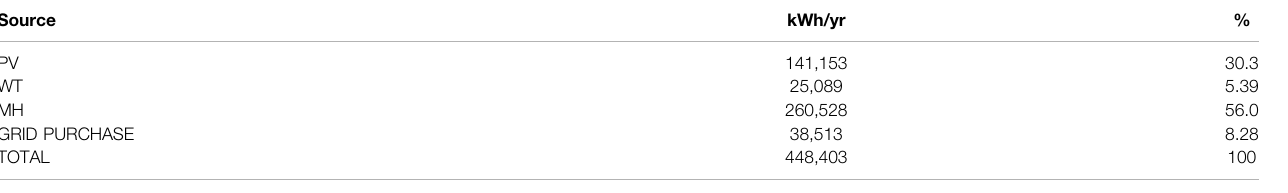
Excess energy and consumption of the optimal